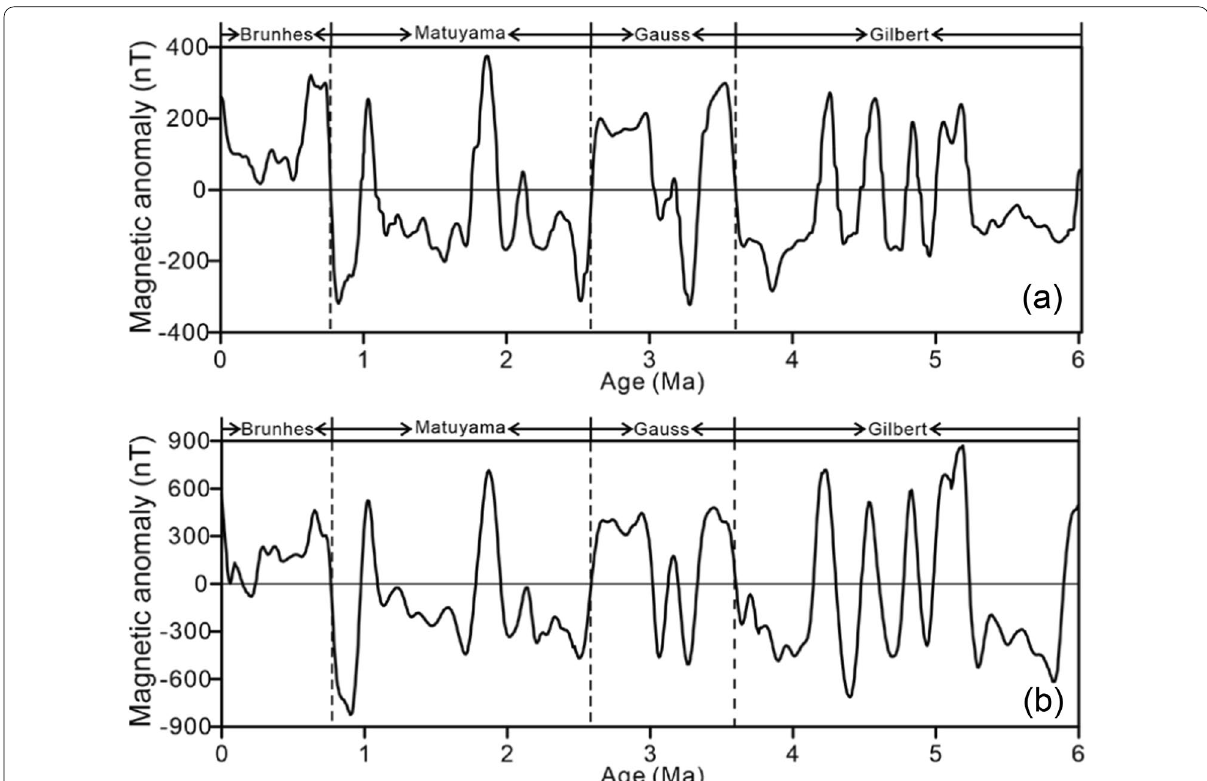
Fig. 16 The synthetic and observed marine magnetic anomalies of profile Area 1 (From Li et al., 2021). a The synthetic marine magnetic anomalies of profile A1. b The observed marine magnetic anomalies of profile A1. Dashed lines show the boundaries of magnetic anomalies of different chron